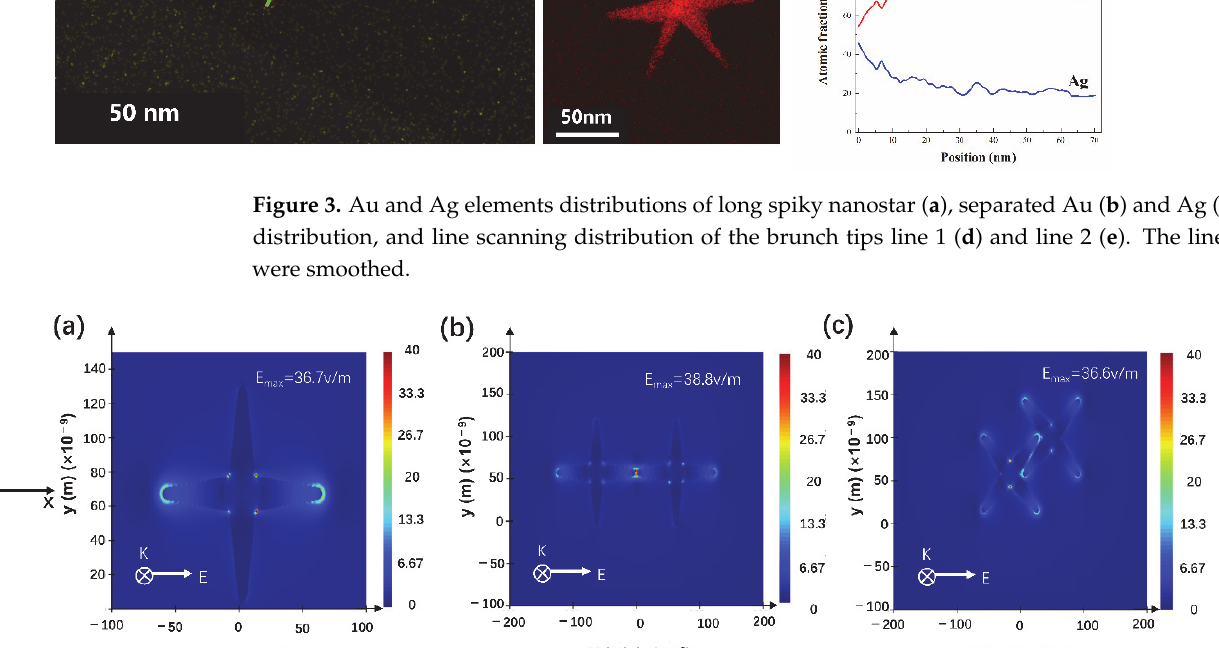
Figure 4. Simulated electric distribution from single nanostar ( a ) colliding tip-top nanostars ( b ) and intercrossed ( c ) long spiky Au-Ag nanostars.